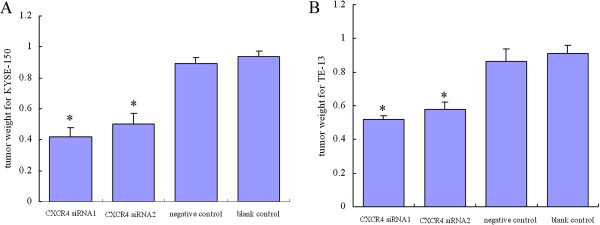
The growth inhibitory effects of CXCR4 were examined in vivo using a xenograft model of esophageal cancer. A. Nude mice were inoculated KYSE-150. Four weeks later, strip nude mice tumor and weigh by electronic balance. The targeted CXCR4 siRNA inhibited tumor growth in a xenograft model (*p <0.05). B. Nude mice were inoculated TE-13 cells. Four weeks later, strip nude mice tumor and weigh by electronic balance. The targeted CXCR4 siRNA inhibited tumor growth in a xenograft model.